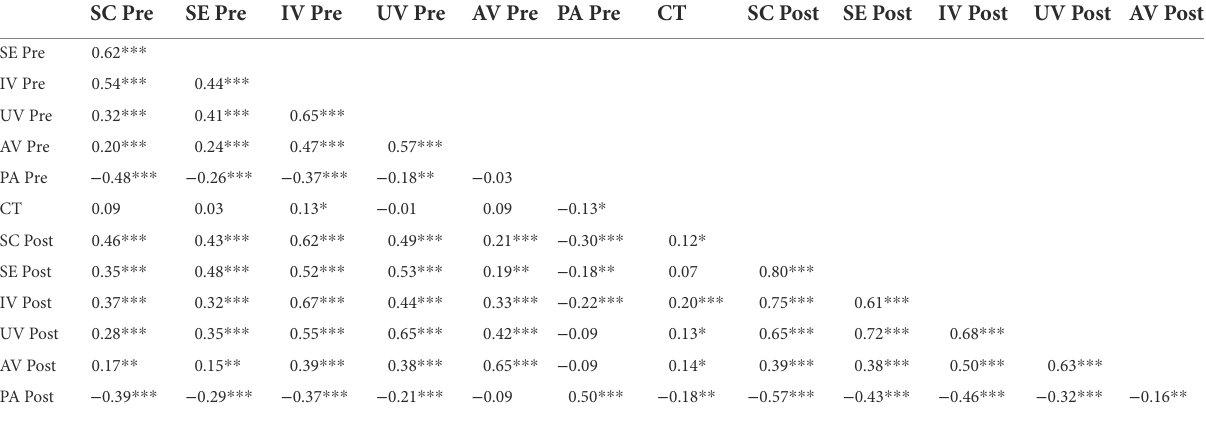
TABLE 3 Correlations of the constructs.